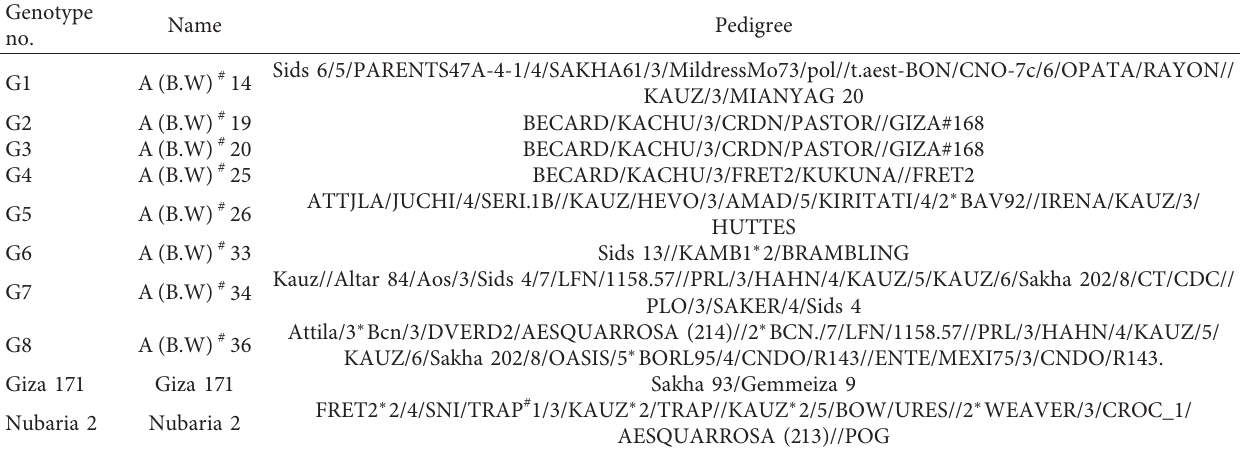
Table 1: Names and pedigree of genotypes used in the study.